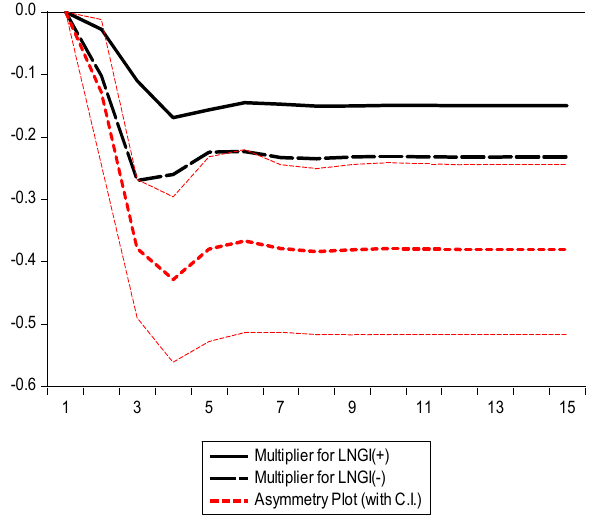
Multiplier for LNEPU(+) Multiplier for LNEPU(-) Asymmetry Plot (with C.I.)